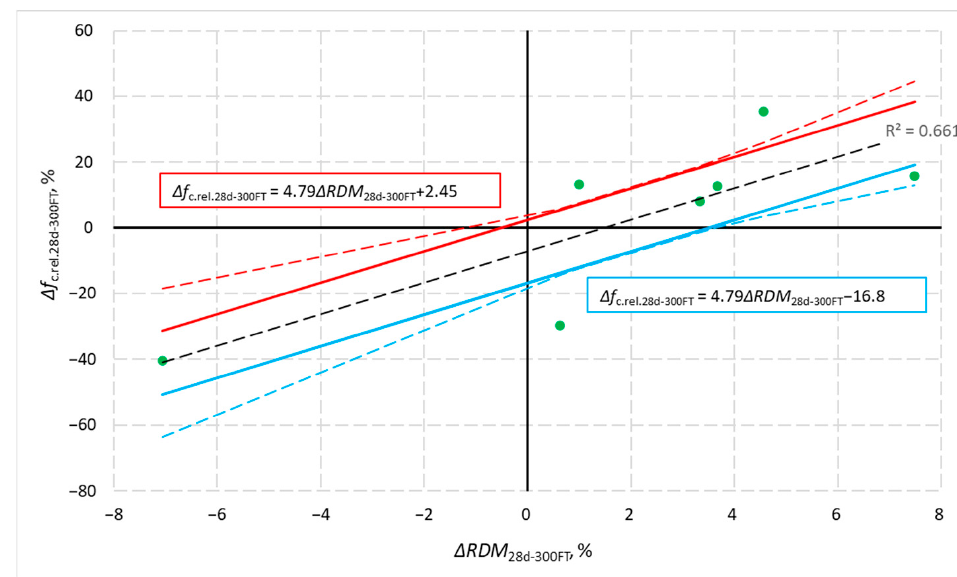
Figure 13. Relationship between the relative changes in mean compressive strength and the differ- ences in the relative dynamic modulus of elasticity obtained from tests of concrete specimens after 300 cycles of freezing and thawing and not-frozen specimens.